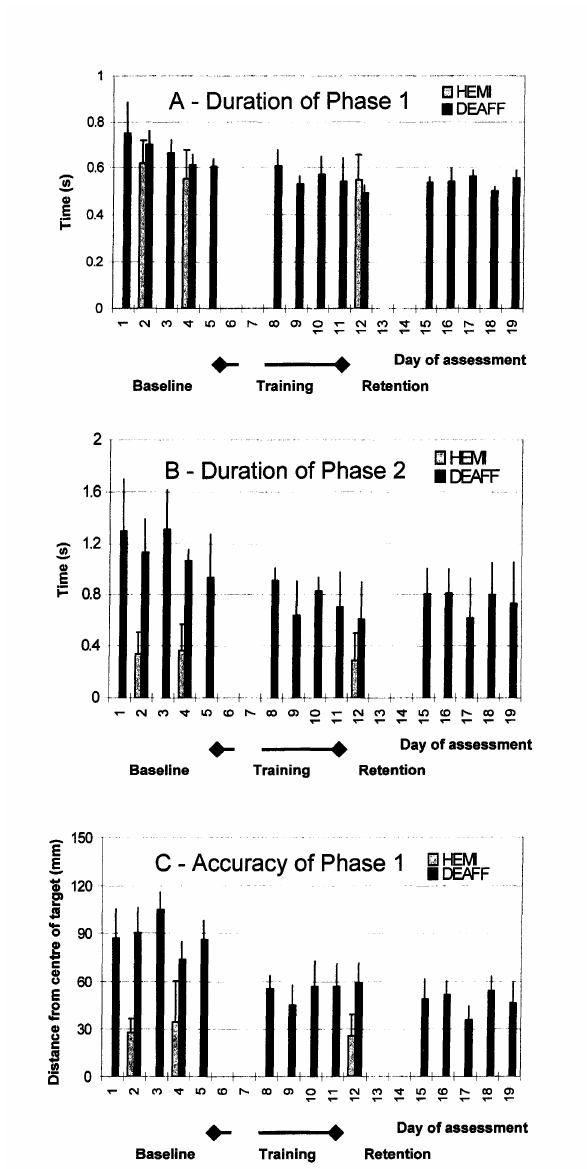
FIG. 1. Kinematic analysis of aiming movements in a deafferented patient and eight hemiparetic